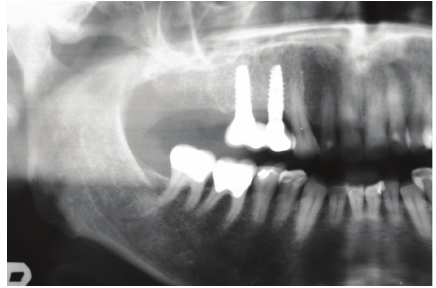
Figure 5: L-PRF membrane.